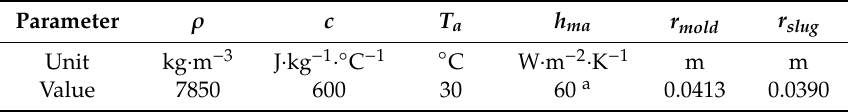
Table 2. Values of parameters used in this study.